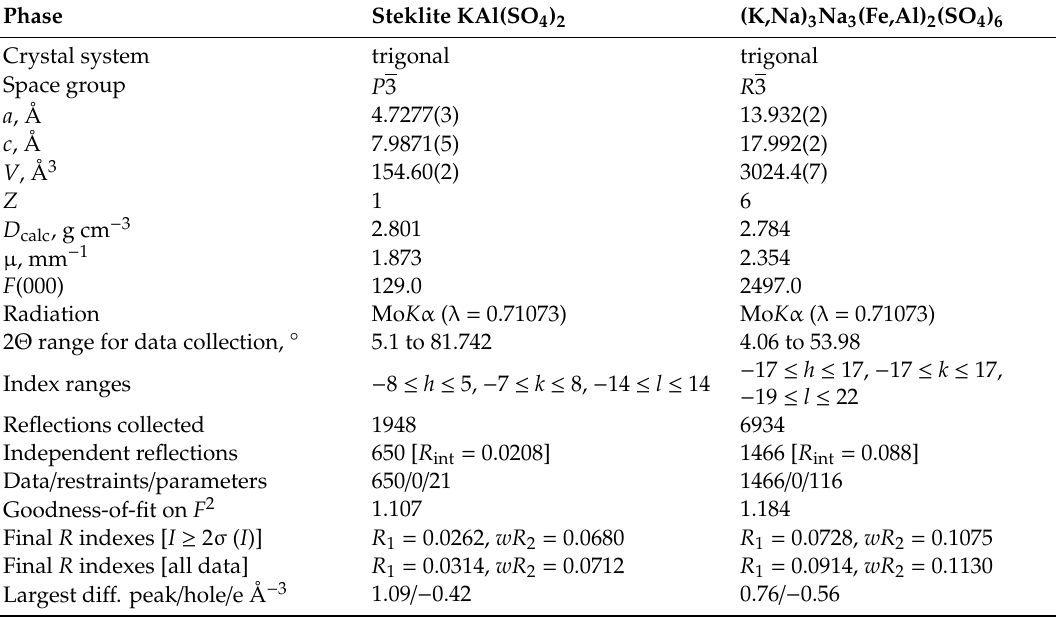
Table 1. Crystal data and structure refinement parameters for both studied sulfates.